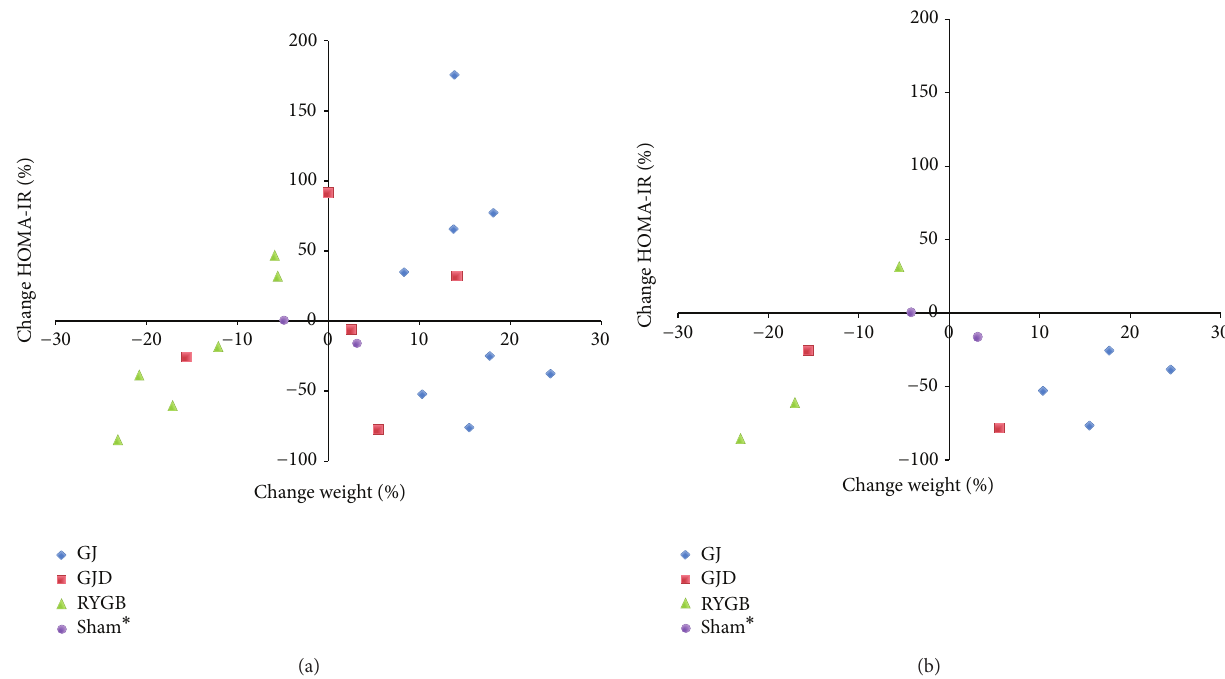
Figure 2: (a) Change in body weight and HOMA-IR by operation. Scatterplot shows percent change in weight and HOMA-IR 8 weeks postoperatively. ∗ Sham pig values are at 2 weeks, as 8-week data was unavailable. (b) Change in body weight and HOMA-IR among high HOMA-IR pigs only. Percent change in weight and HOMA-IR 8 weeks postoperatively in pigs with above median baseline HOMA-IRs. ∗ Sham pig values are at 2 weeks, as 8-week data was unavailable.